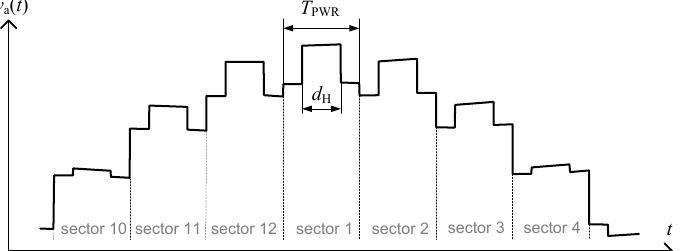
Figure 11. Fragment of phase voltage waveform for the PWR modulation using the S MC n